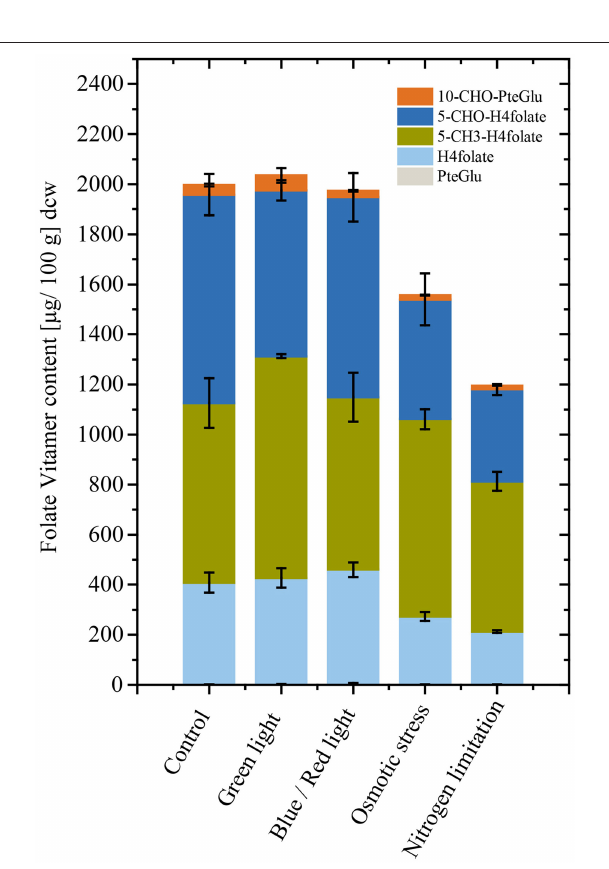
FIGURE 4 | Total folate content and vitamer distribution after conditional changes applied for 24h in triplicates. Chlorella sp. isolate cultivations show reduced folate content when exhibited to osmotic stress and nitrogen limitation. Light wavelength changes did not affect folate contents when shifted for